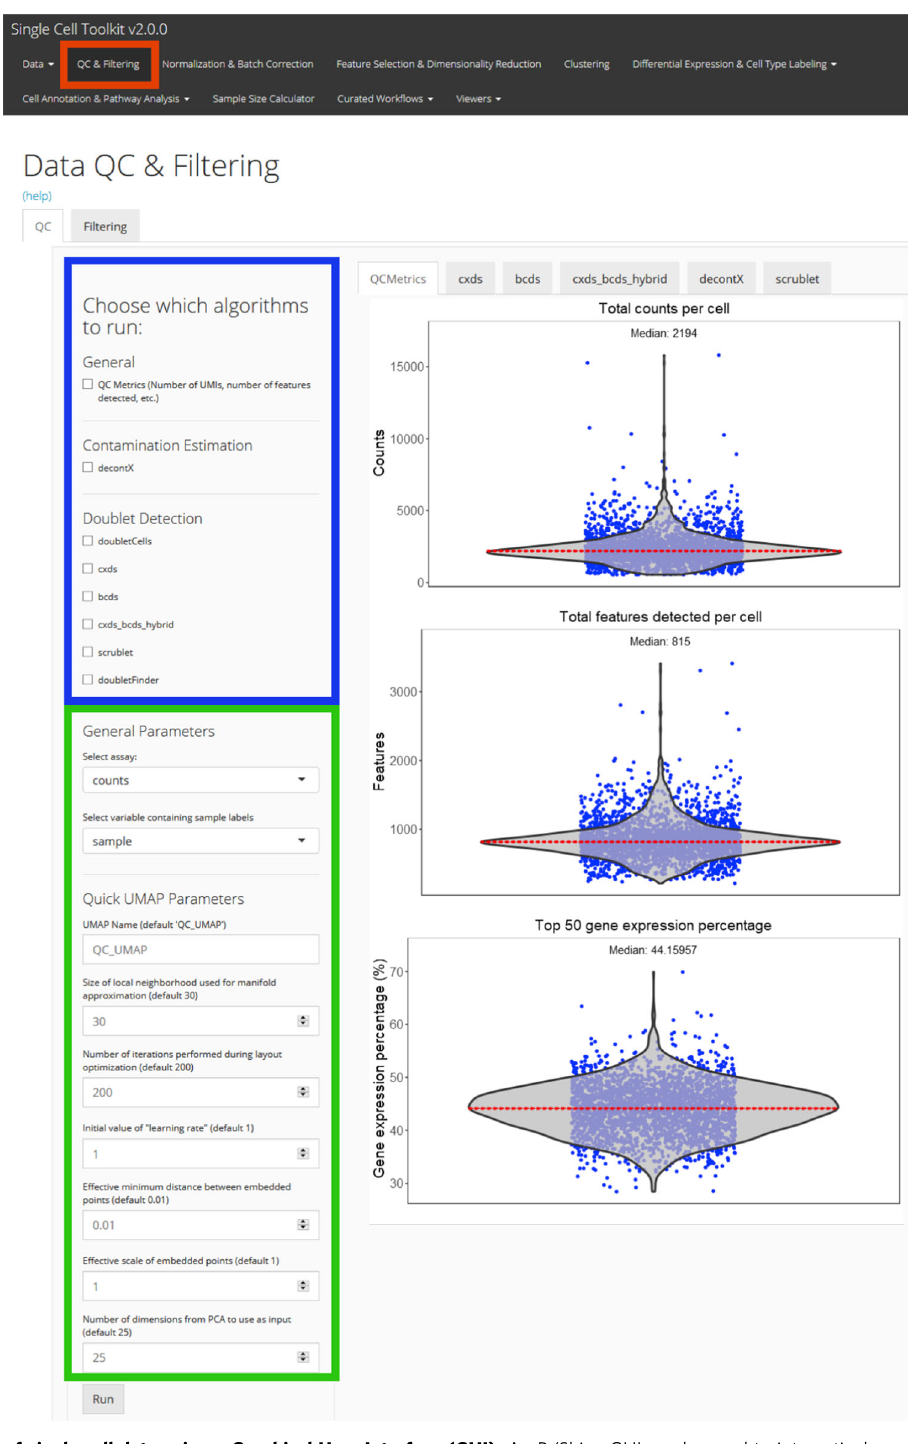
Fig. 3 Interactive QC of single cell data using a Graphical User Interface (GUI). An R/Shiny GUI can be used to interactively run QC algorithms in the singleCellTK package. A screenshot of the “ Data QC & Filtering ” tab from the interactive GUI is shown. After importing the data, quality control is performed within the “ QC & Filtering ” tab (red) of the user interface. QC algorithms are chosen from a list (blue), while speci fi c parameters may be speci fi ed as well (green). Plots displaying metrics generated by each QC tool will appear to the right in a